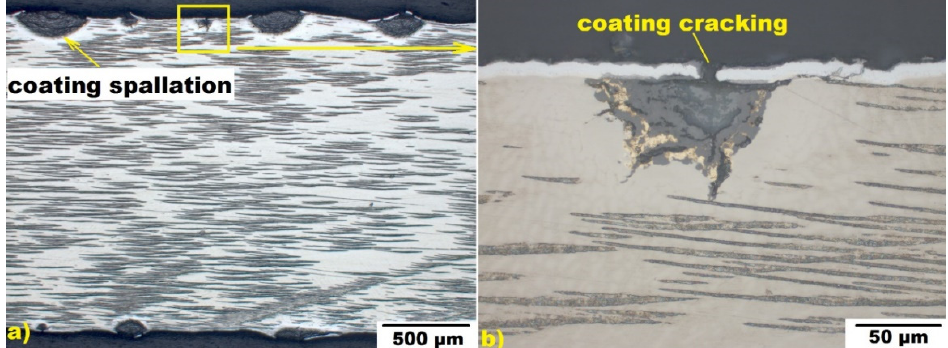
Figure 5. Optical images of the cross-section of the ZrO 2 /Cr-100 sample after 50 thermal cycles at different magnification: ( a )—×50; ( b )—×200.